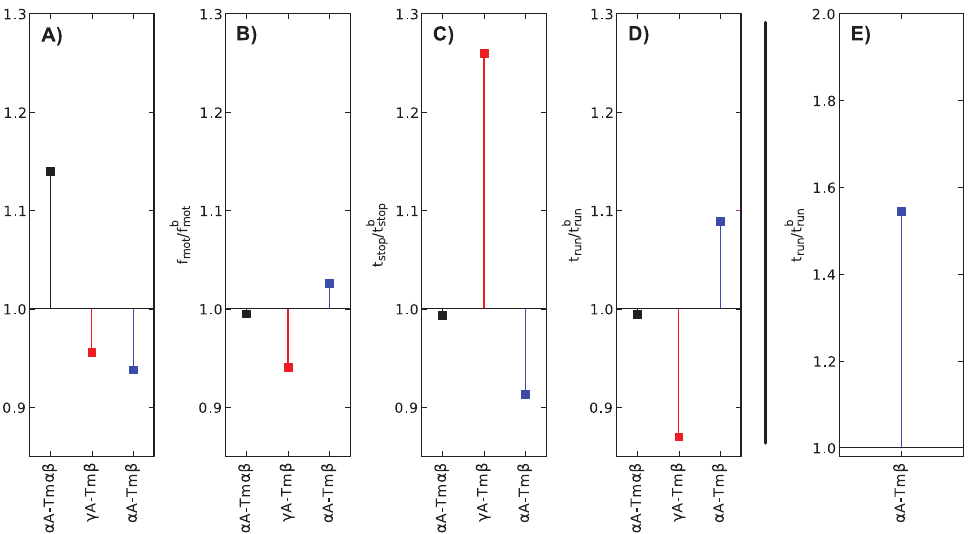
Figure 6. Fold changes in invitro actin sliding features in model simulations. A–D) Simulated motility features averaged over whole N range. The fold changes were calculated in the same way as for the experimental data (Fig. 4). The altered conditions a A-Tm ab , c A-Tm b , and a A-Tm b are normalized by the baseline condition ( a A, c A, c A-Tm ab ). E) t stop fold change for low L range ( N ~ 10,11, ... ,40 ).